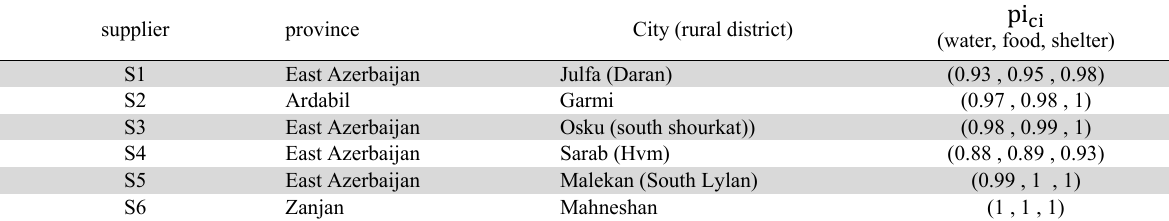
The case study relief supplier points